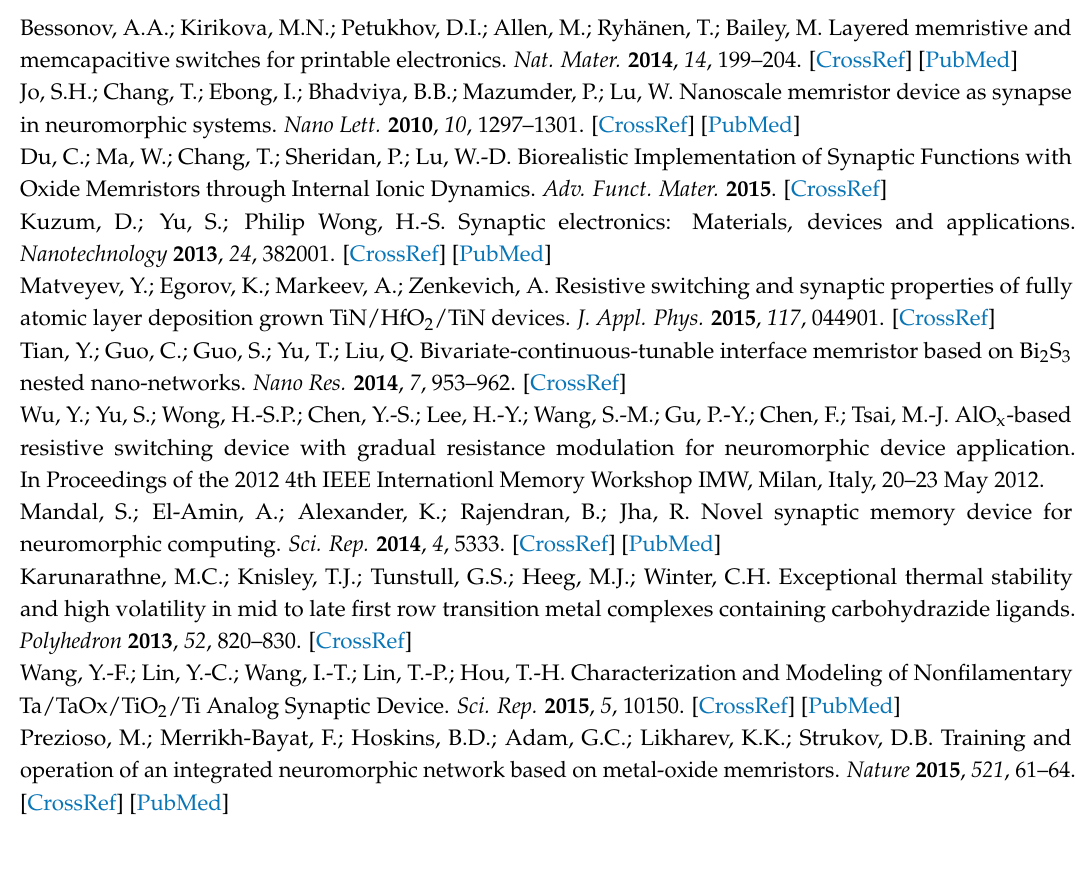
Figure S1: Device reliability evaluations in HfO 2 -based synaptic devices, Figure S2: AC pulse response in TaN/HfO 2 /Pt devices, Figure S3: Current transport analysis in Ag/HfO 2 /Pt